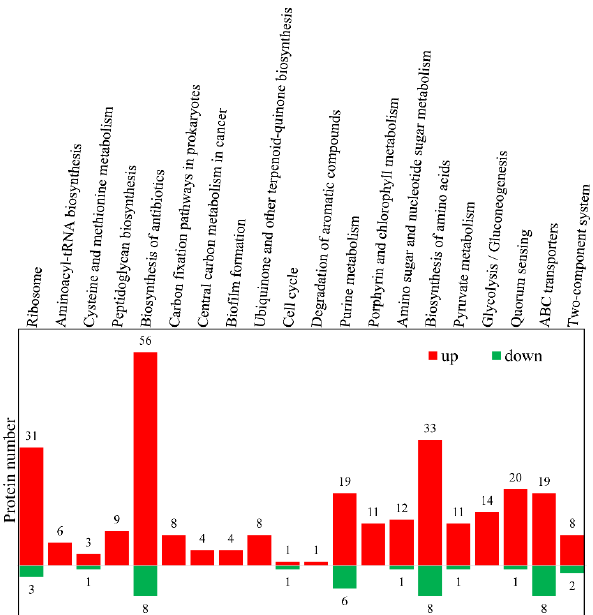
Figure 5. Top 20 Kyoto Encyclopedia of Genes and Genomes (KEGG) biological pathway classification histograms for differential proteins in DH versus DC. The x-axis represents the enriched KEGG pathway, and the y-axis represents the number of proteins that were significantly upregulated or downregulated expressed in DH versus